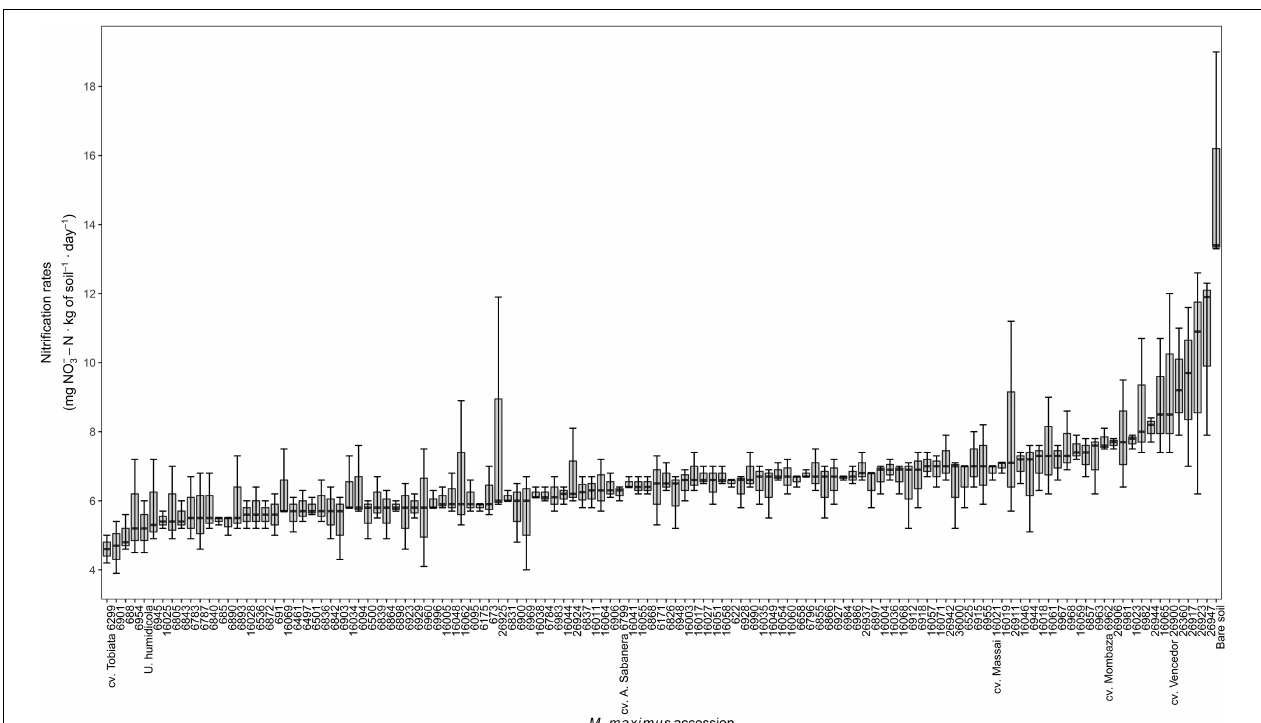
FIGURE 1 | Nitrification rates of soil of 119 germplasm accessions of M. maximus after 12 months of planting in greenhouse conditions. Nitrification rates are expressed as the slope of a linear regression between concentration of NO 3 − over time after 20 days of incubation ( n = 3). U. humidicola and bare soil are positive and negative controls,